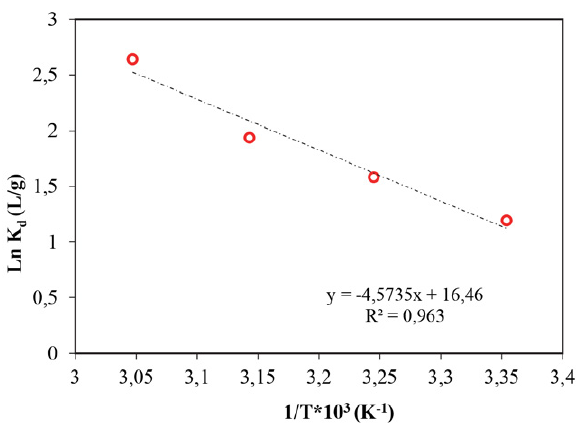
Figure 12. The thermodynamic behavior of P ion sorption using MnFe 2 O 4 nanoparticles (Conditions: mixing rate = 500 rpm, pH = 6, MnFe 2 O 4 dose = 2 g/L, P ion concentration = 10 mg/L, and con- tact time = 60 min)